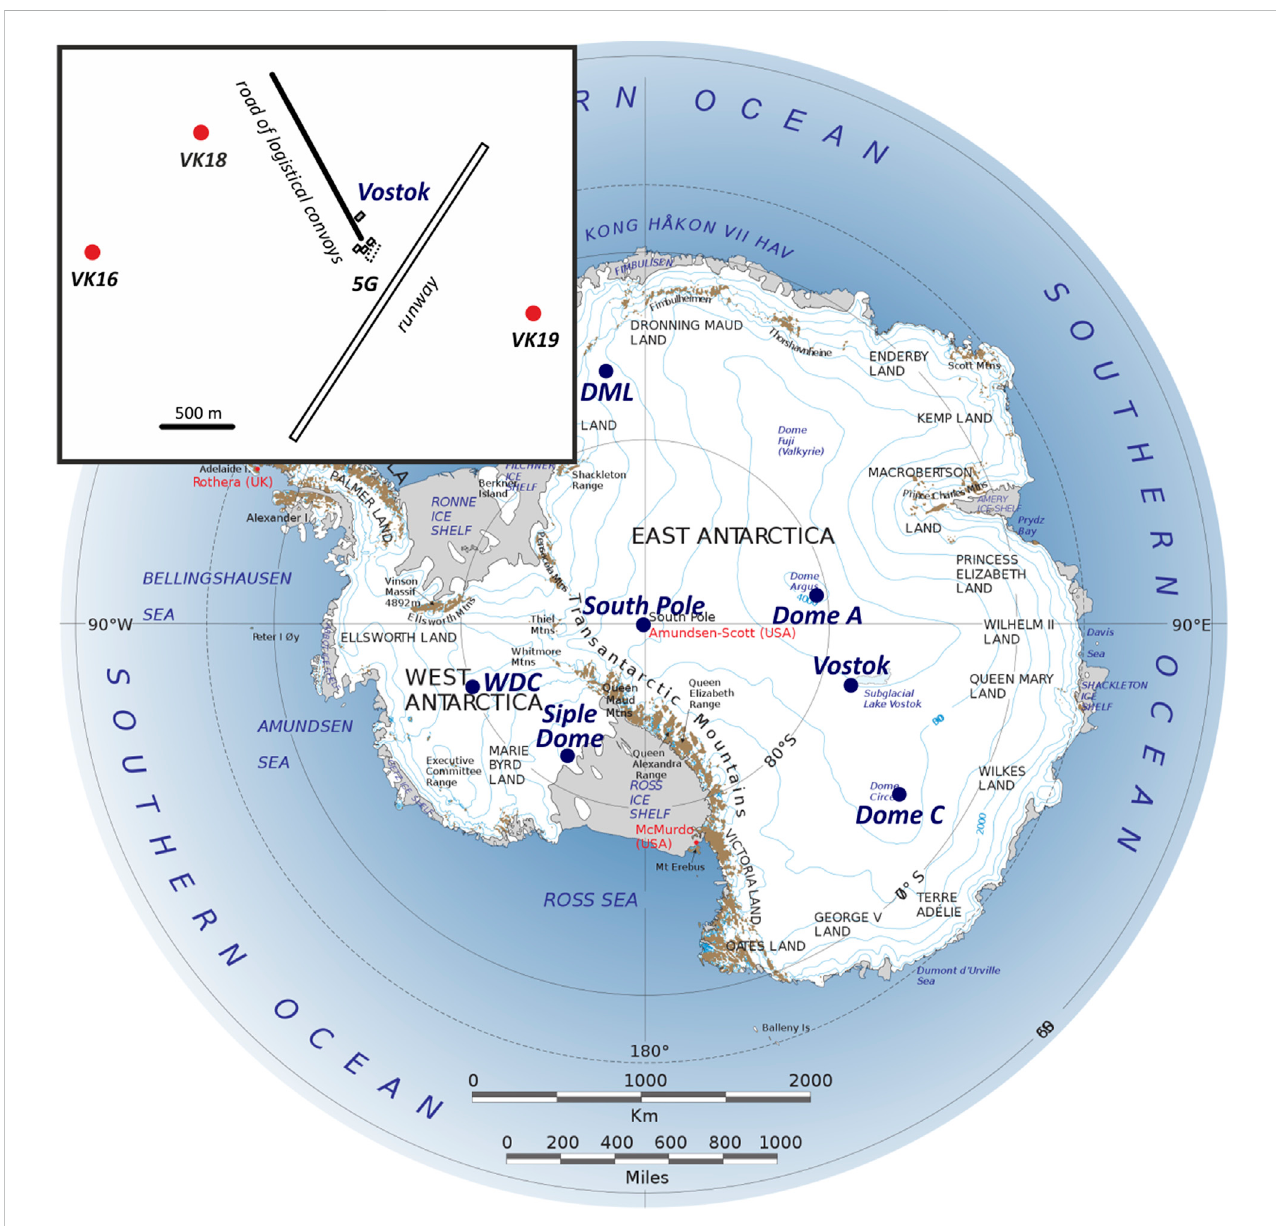
LocationsoftheAntarcticcoresitesmentionedinthepaper.IntheinsertaschemeoftheVostokstationvicinityisshownwiththelocationofVK16,VK18, and VK19 drilling sites. The source for the map of Antarctica: